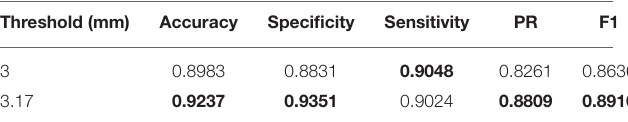
TABLE 6 | Summary of the prediction results.